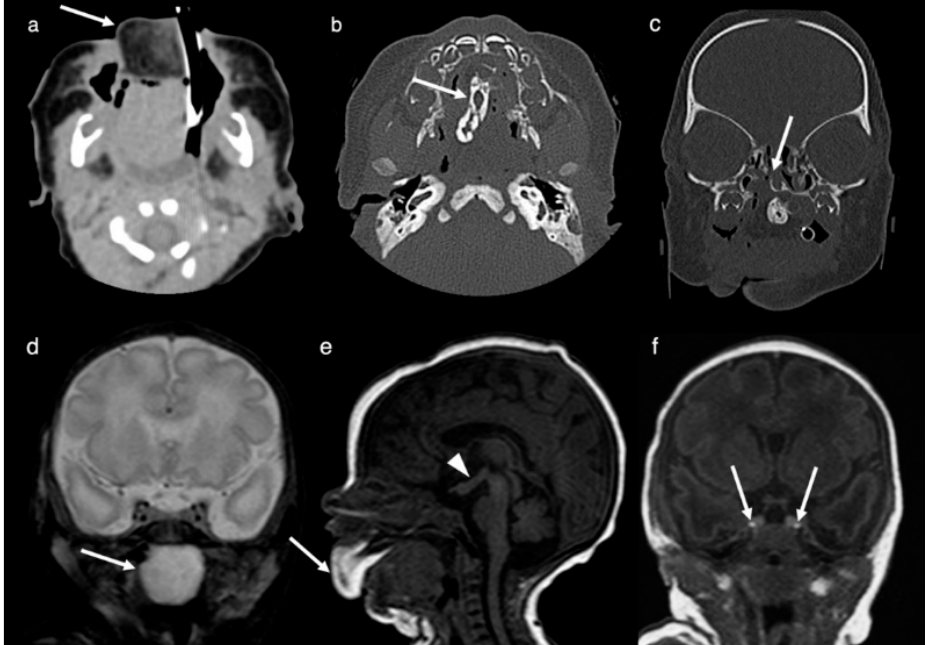
Figure 1. Images obtained at the second day of life. Axial CT-image ( a ), axial CT-image (bone algorithm, ( b )), coronal CT-image (bone algorithm, ( c )), coronal T2-weighted MR-image ( d ) and sagittal T1-weighted MR-image ( e ) show a heterogeneous mass centered in the oral cavity and protruding anteriorly through the mouth. The mature teratoma is composed out of fatty tissue anteriorly (arrows in ( a , e )), a mineralized/bony component in the midline (arrow in ( b )) and a cystic component posteriorly within the naso-/oropharynx (arrow in ( d )). A cleft palate with corresponding defect in the hard palate can be seen in ( c ) (arrow). The tuberomammillary fusion is shown in ( e ) (arrowhead). Coronal T1-weighted MR-image ( f ) documents a complete duplication of the pituitary gland including the pituitary stalk. The bright spots of the duplicated posterior pituitary are clearly depicted (arrows in ( f )).